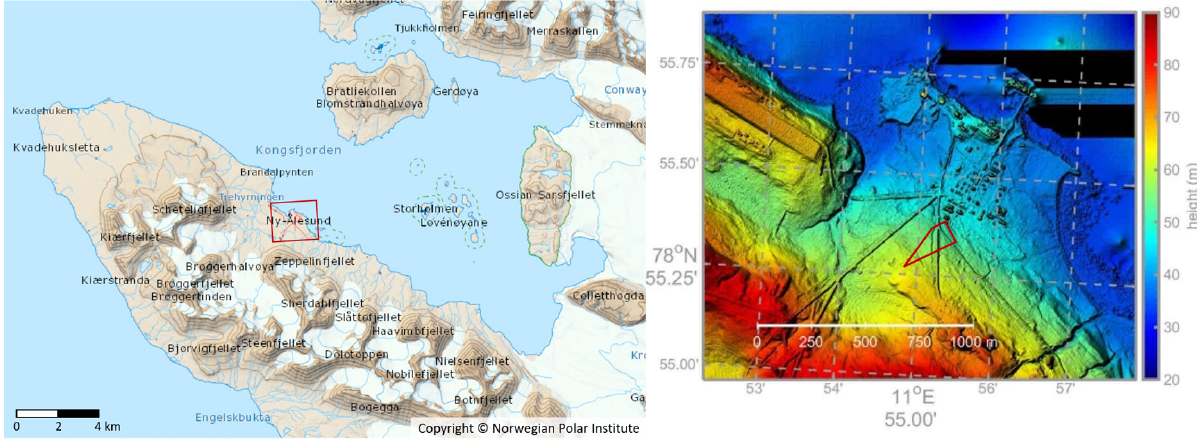
Figure 1. The left panel shows the location of Ny-Ålesund in the Kongsfjord (Copyright © Norwegian Polar Institute, http://toposvalbard. npolar.no, last access: 8 June 2021). The right panel is a visualization of a digital elevation model published by Boike et al. (2018) with the setup marked using a red